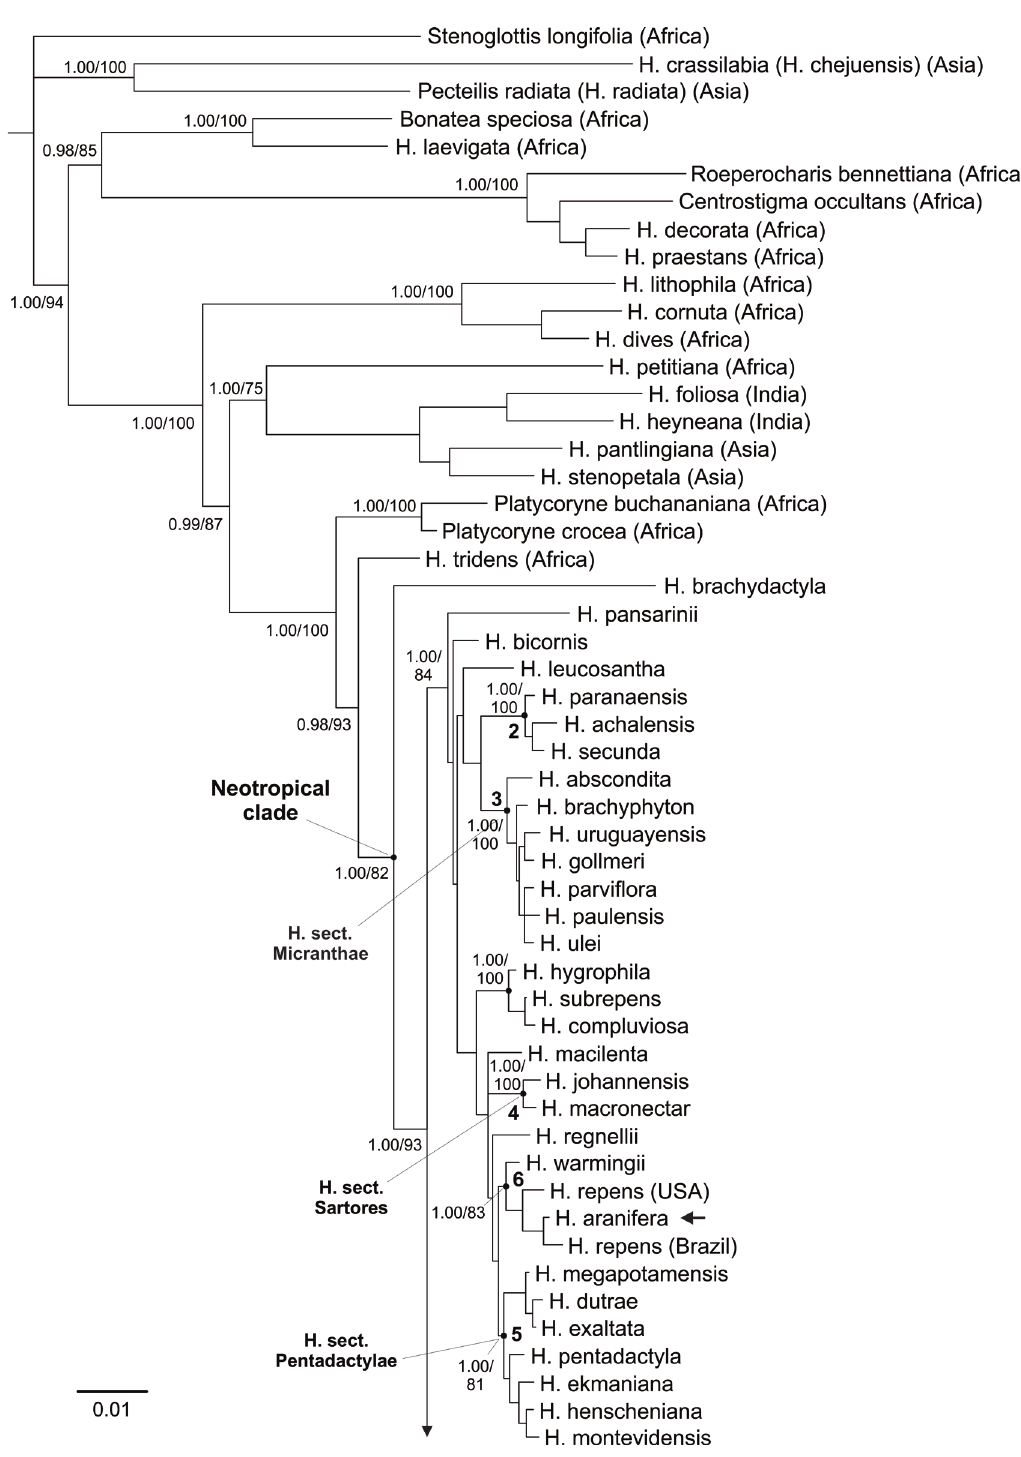
Fig. 1 ( part 1). Bayesian 50% majority-rule consensus tree of the combined ITS, ETS, matK-trnK and rps16-trnK datasets. Numbers next to the nodes represent the posterior probabilities (PP) from the Bayesian analysis and bootstrap percentages (BP) from parsimony analyses. Only values of major clades are shown. Bootstrap percentages ≤ 50% are indicated by a dash (-). Neotropical subclades are numbered according to Batista et al. (2013). Habenaria karstica J.A.N.Bat. sp. nov. is highlighted in bold. Species of the Habenaria repens complex morphologically similar to H. karstica are indicated by